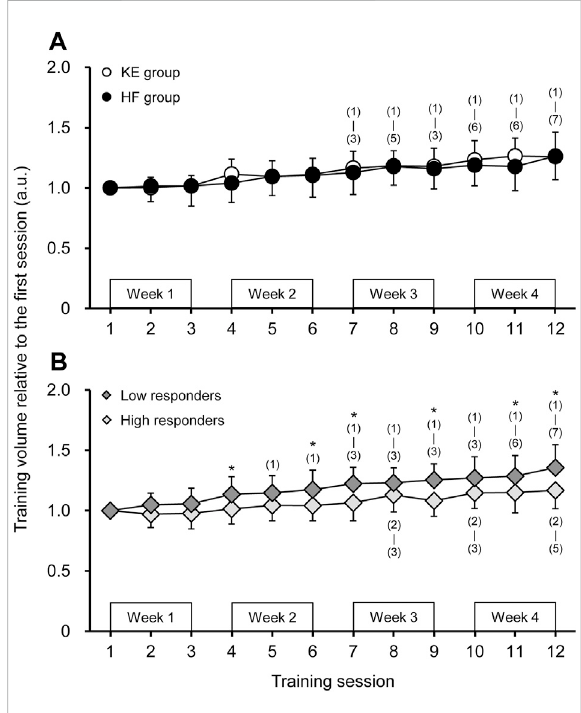
FIGURE 2 Training volume in each training session in (A) the knee extension (KE) and hip fl exion (HF) groups and in (B) the high and low responders. The number inside the parenthesis indicates the training session,where asigni fi cant difference wasfound. *,a signi fi cant difference was observed between the high and low